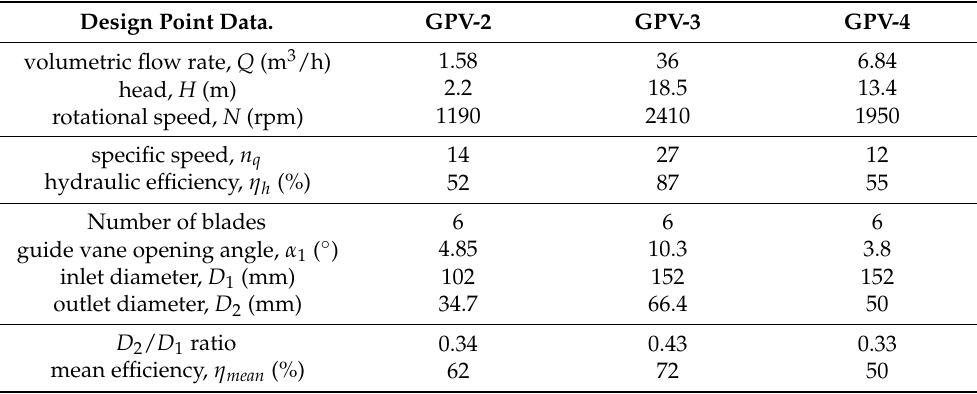
Figure 17. GPV-4 impact in consumer and upstream node pressure head and pressure. Table 3. Important operational and design parameters. Design Point